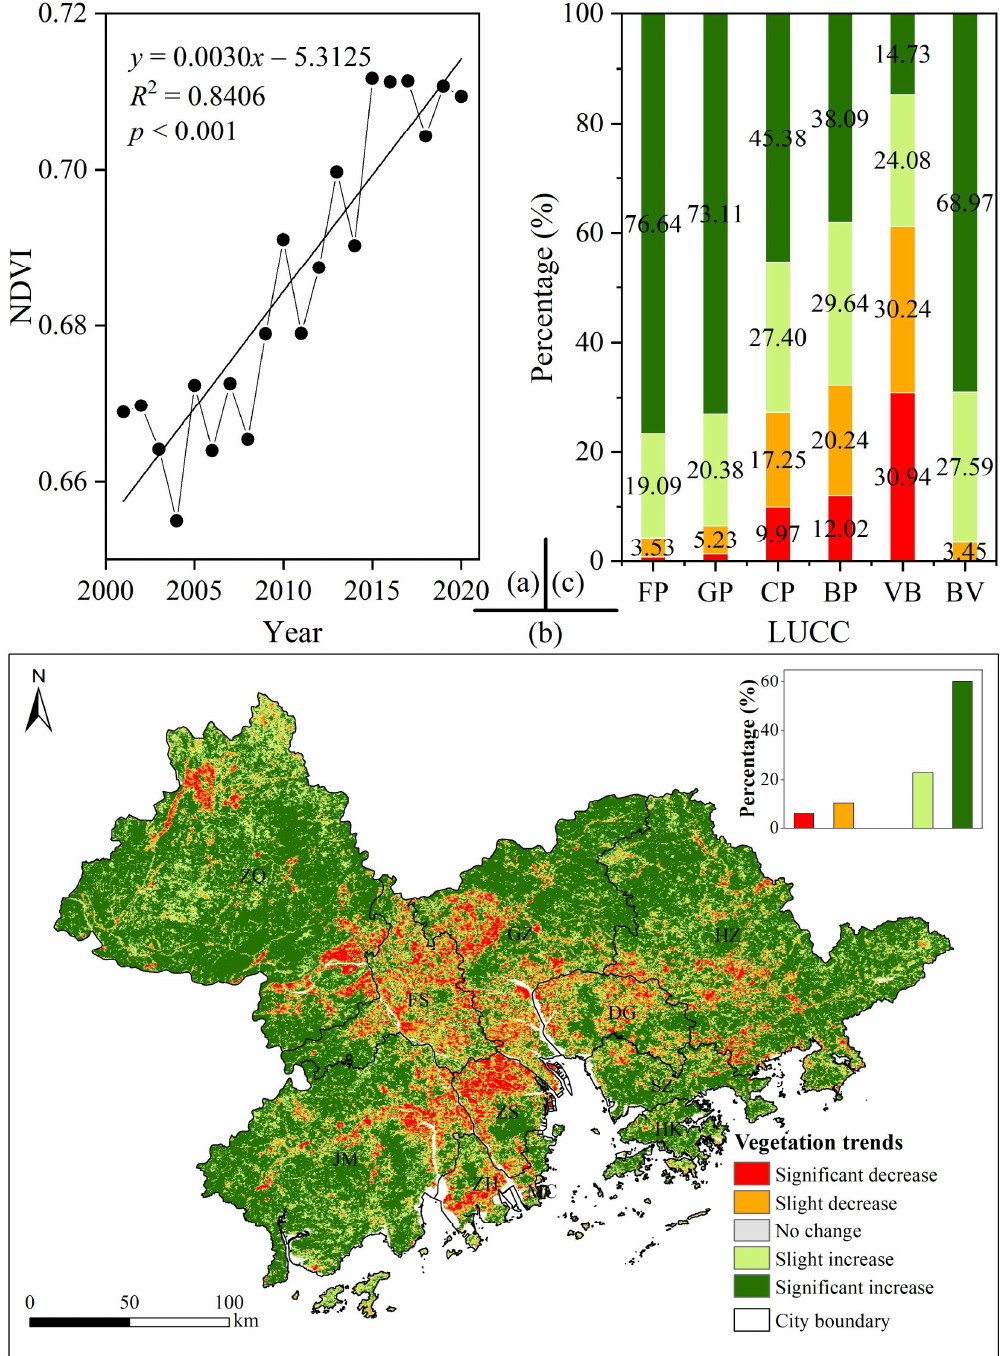
Figure 3. Trends of inter-annual NDVI in the GBA from 2001 to 2020. ( a ) The area-averaged NDVI trend; ( b ) the spatial pattern of NDVI trend; ( c ) the area percentage of NDVI trend for main LUCC types. FP—forest persistence; GP—grassland persistence; CP—cropland persistence; BP—built-up persistence; VB—vegetation to built-up; BV—built-up to vegetation.